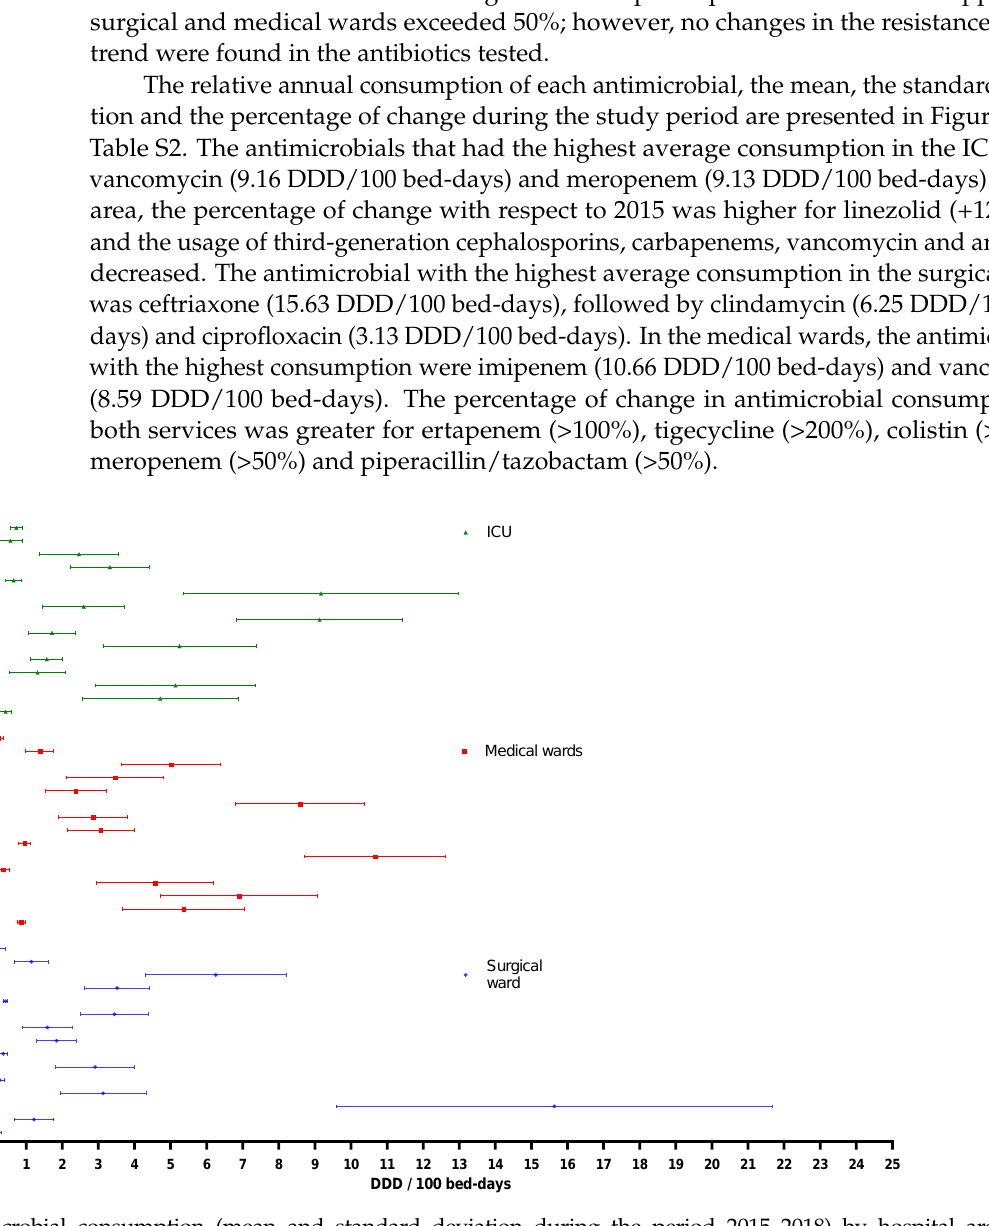
Figure 3. Antimicrobial consumption (mean and standard deviation during the period 2015–2018) by hospital areas. DDD = defined daily doses. AMK = amikacin, CAZ = ceftazidime, CIP = ciprofloxacin, CLI = clindamycin, COL = colistin, CRO = ceftriaxone, ETP = ertapenem, IPM = imipenem, LNZ = linezolid, MEM = meropenem, OXA = oxacillin, SAM = ampicillin/sulbactam, TIG = tigecycline, TZP = piperacillin/tazobactam, VAN = vancomycin. ICU = intensive care unit .